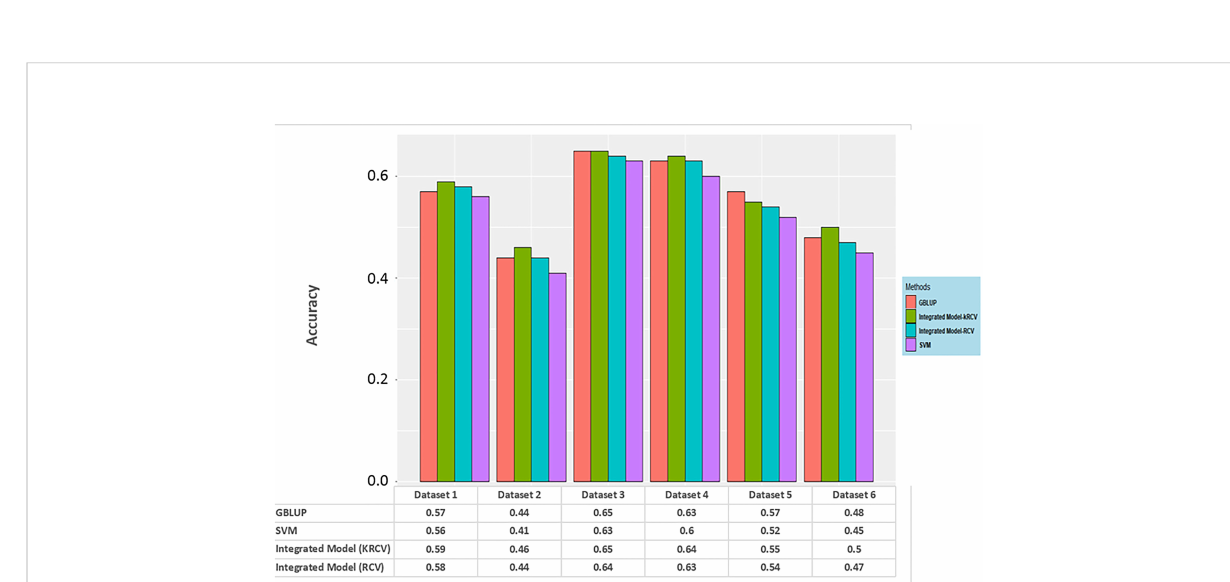
FIGURE 4 Prediction accuracy for different genomic selection models on a real